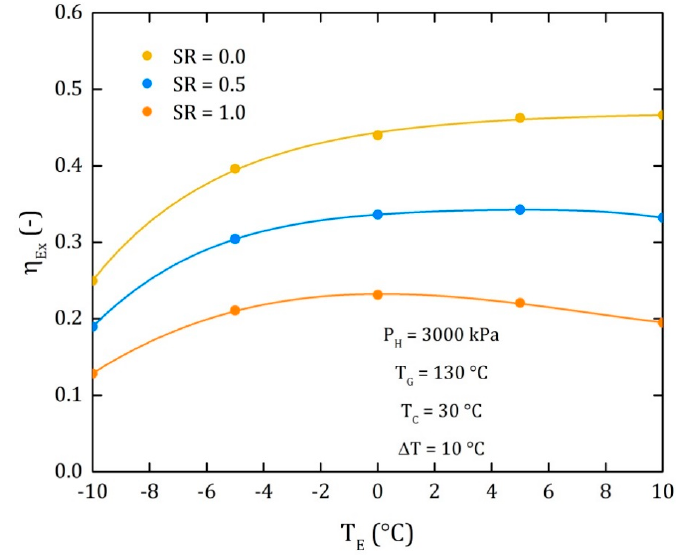
Figure 7. η EX as a function of T E for Model II at three di ff erent values of